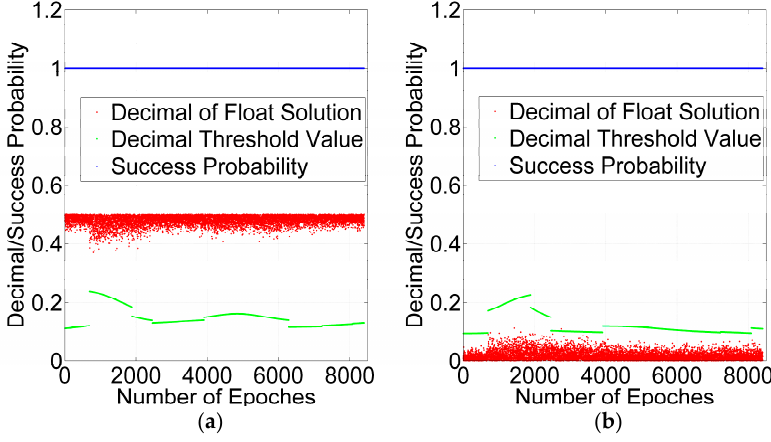
Figure 12. Validation by success probability and decimal test for GPS: 1.5 Cycles ( a ); 1 Cycle ( b ).